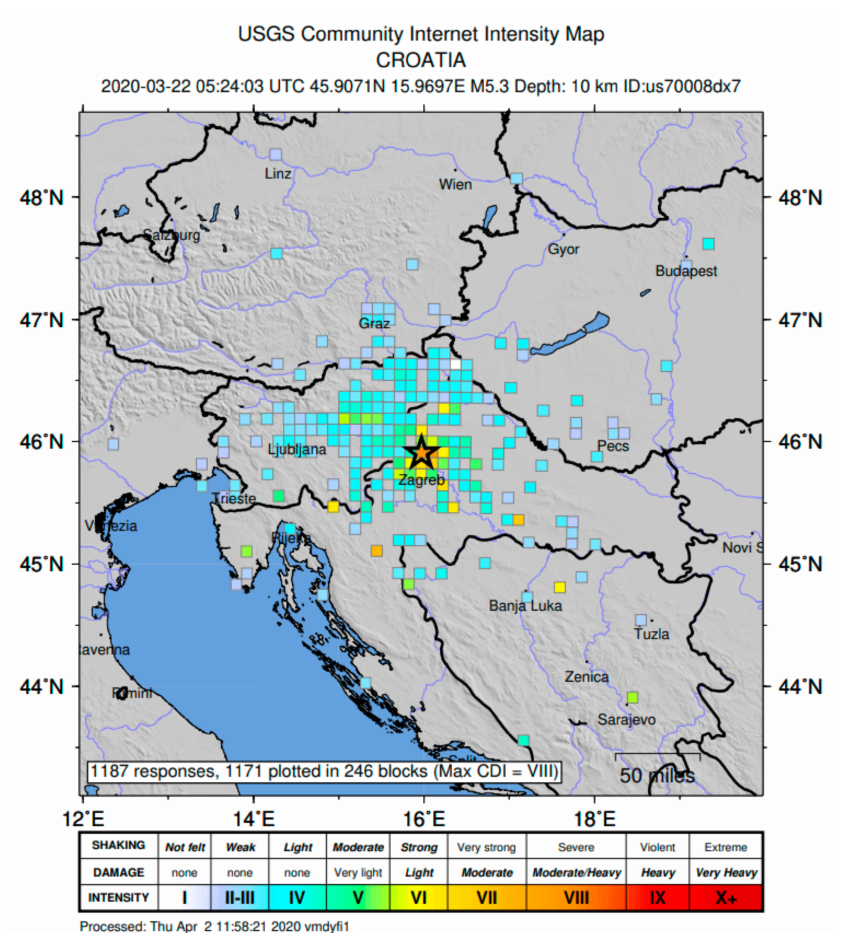
Figure 3. Intensity map according to data collected by USGS